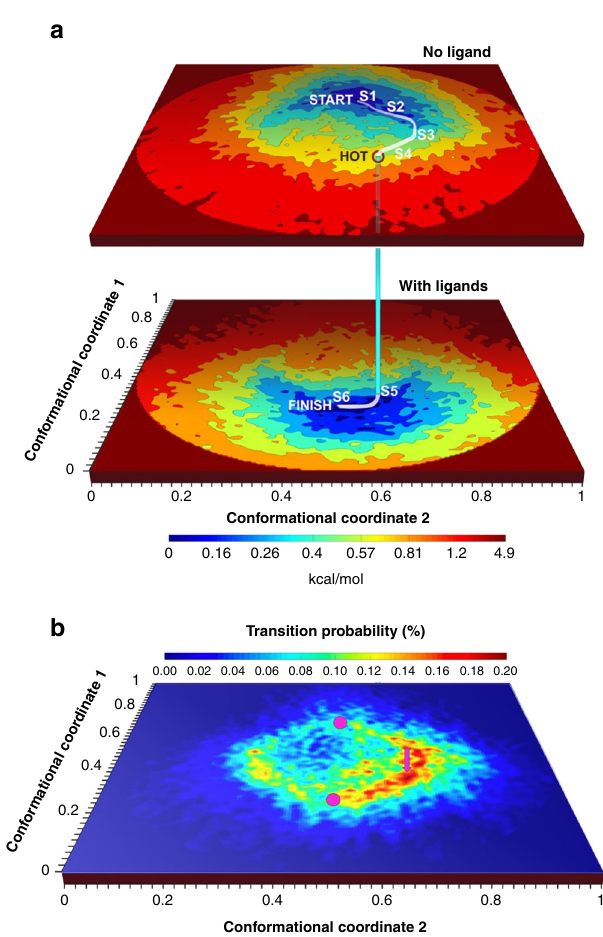
Fig. 1 Energy landscapes with and without ligands, and transition probability map. a Energy landscapes without ligands (upper surface), and with ligands (Ca 2 + , ATP, and caffeine) (lower surface). The landscapes are described in terms of the most important two of a common set of orthogonal conformational coordinates. The curved path represents a high- probability route to the binding of ligands. This path starts at the minimum- energy conformation of RyR1 without ligands ( “ START ” ), follows the conduit of lowest energy to a point with a high probability of transition to the with-ligands energy landscape ( “ HOT ” ), and terminates at the minimum-energy conformation with ligands ( “ FINISH ” ). Six representative conformational states along the path, in white, are selected for validation with molecular dynamics simulations (S1 – S6). b Probability map for transitions from the energy landscape without ligands to the energy landscape with ligands. The axes are the same as in Fig. 1a, with magenta discs indicating the positions of the minima of the energy landscapes. The magenta arrow indicates the position of the transition